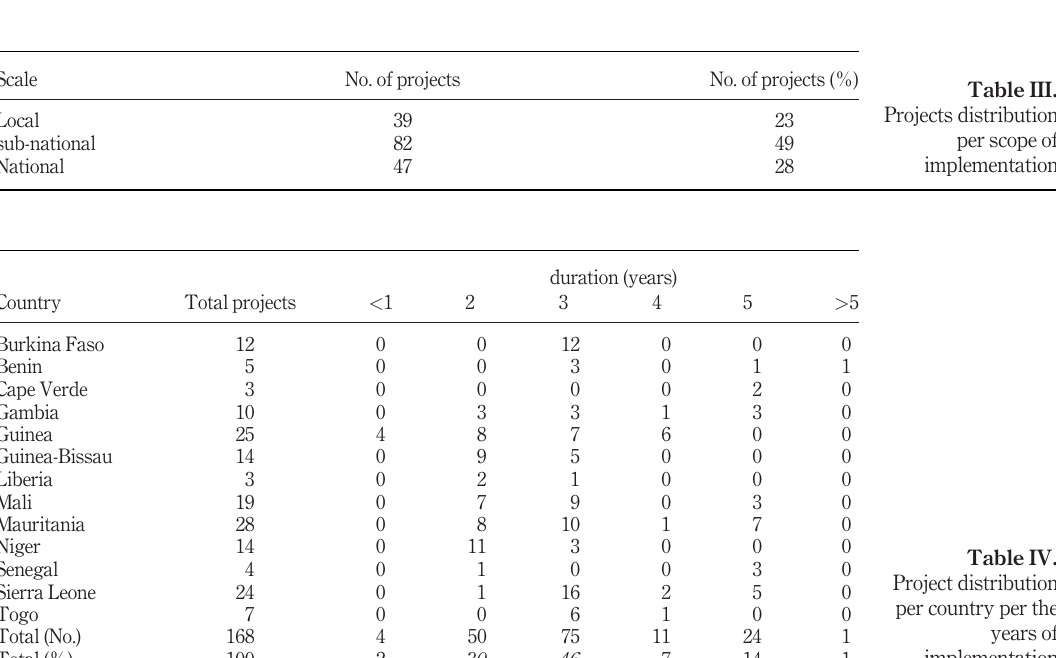
Figure 3. Project